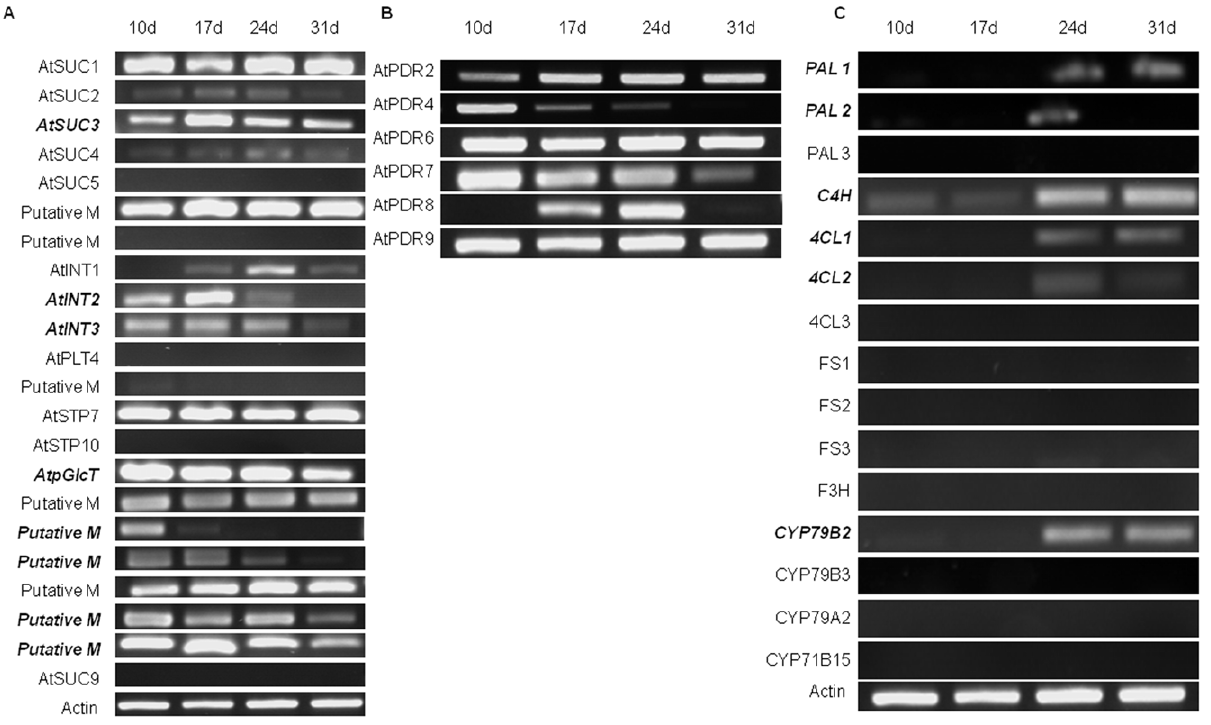
Figure 3. Arabidopsis root gene expression profiles. (A) sugar transporters, (B) ABC transporters, and (C) genes involved in secondary metabolism, as measured by semi-quantitative RT-PCR. Gene names are listed on the left side. The time points at which root tissues were collected are shown along the top. Bold and italicized text indicates genes whose expression profiles are most consistent with the GC-MS analysis of collected exudates. doi:10.1371/journal.pone.0055731.g003 involved in their metabolism. For example, beta-alanine positively correlated to the functional gene adenylosuccinate synthase [EC:6.3.4.4] which is involved in the alanine, aspartate and glutamate metabolism pathway (Table S5). Likewise, glycine positively correlated with sarcosine oxidase, subunit alpha [EC:1.5.3.1] and sarcosine oxidase, subunit beta [EC:1.5.3.1] functional genes involved in the glycine, serine and threonine metabolism pathway (Table S5). On the other hand, 41 functional genes involved in Amino Acid Metabolism negatively correlated with asparagine. Some functional genes that negatively correlate with asparagines were: shikimate dehydrogenase [EC:1.1.1.25], hydroxypyruvate reductase [EC:1.1.1.81], or anthranilate phos- phoribosyltransferase [EC:2.4.2.18](Table S5). Similarly, the functional gene farnesyl diphosphate synthase [EC:2.5.1.1